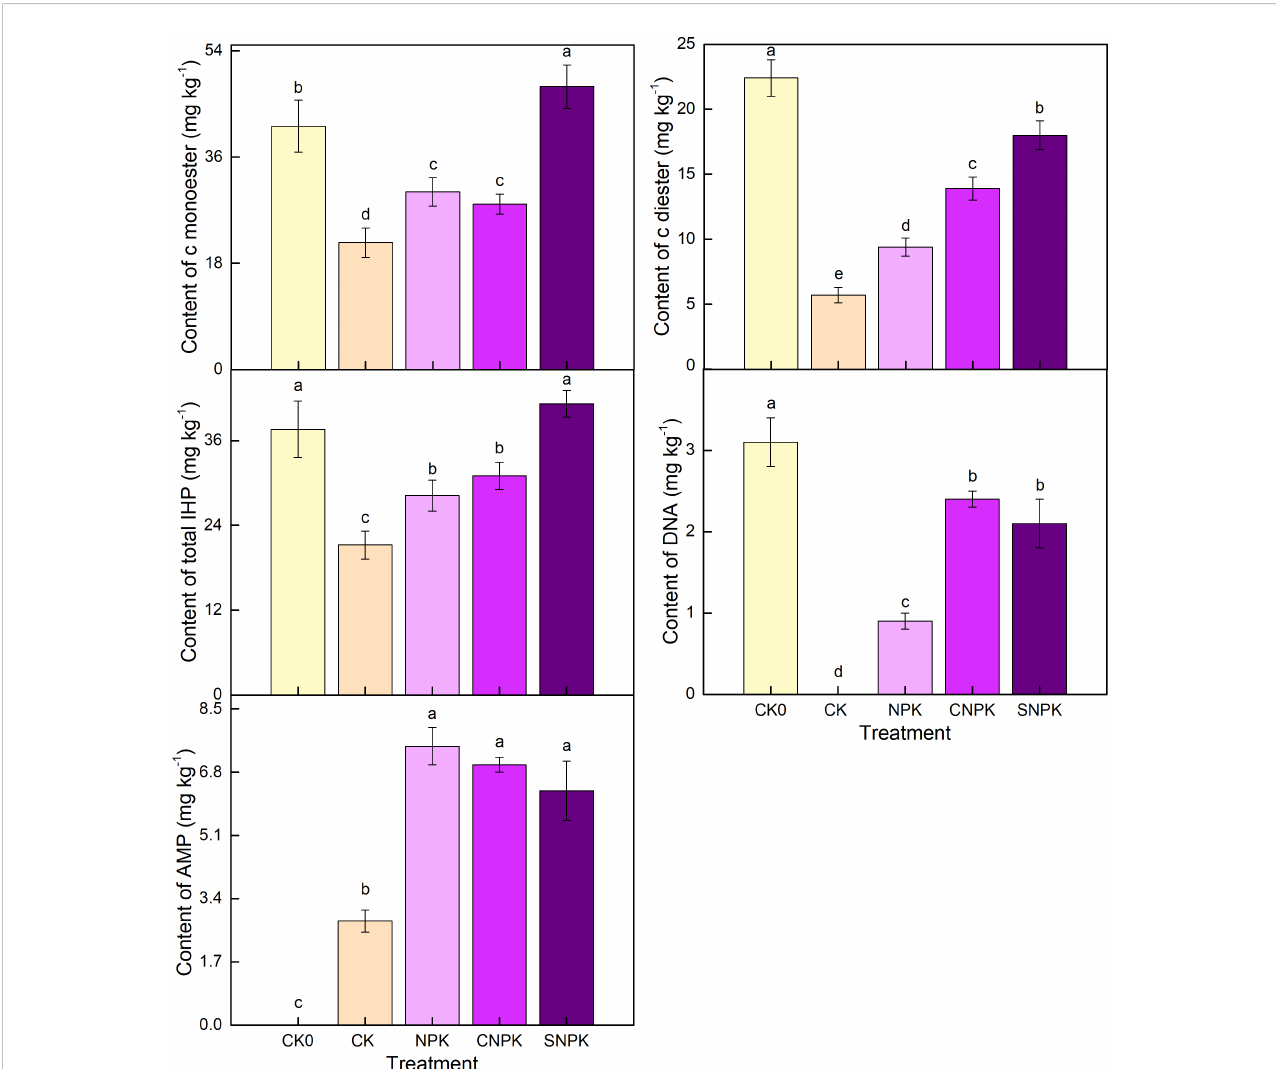
FIGURE 7 Effects of different treatments on c monoester, c diester, total inositol hexakisphosphate, adenosine monophosphate (AMP), and deoxyribonucleic acid (DNA) by solution 31-phosphorus nuclear magnetic resonance spectra. Error bars represent standard deviation, n = 3. Different letters in a column indicate signi fi cant differences at the 0.05 level. c: denotes the correction for degradation products. CK0: initial soil; CK: non-fertilizer; NPK: NPK fertilizer; CNPK: biochar + NPK fertilizer; SNPK: corn stover + NPK fertilizer.